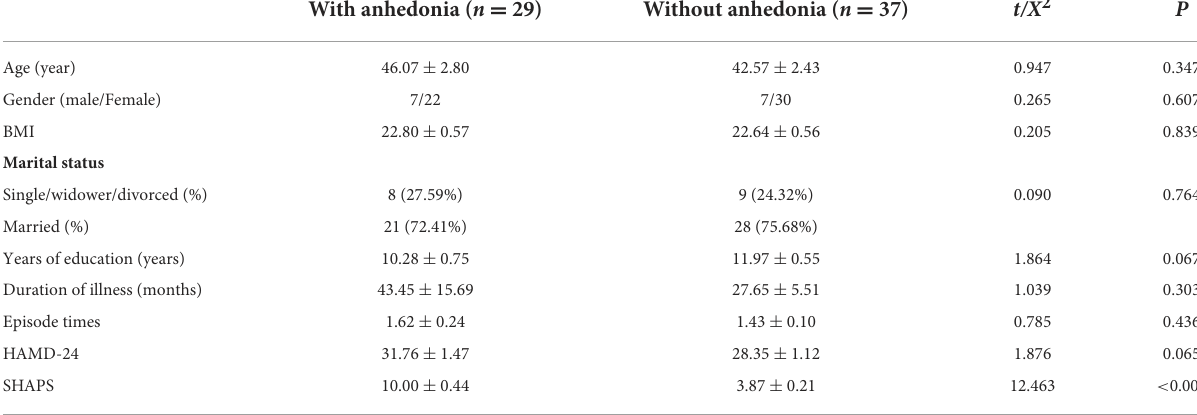
TABLE 2 Demographic and clinical data of MDD patients with or without